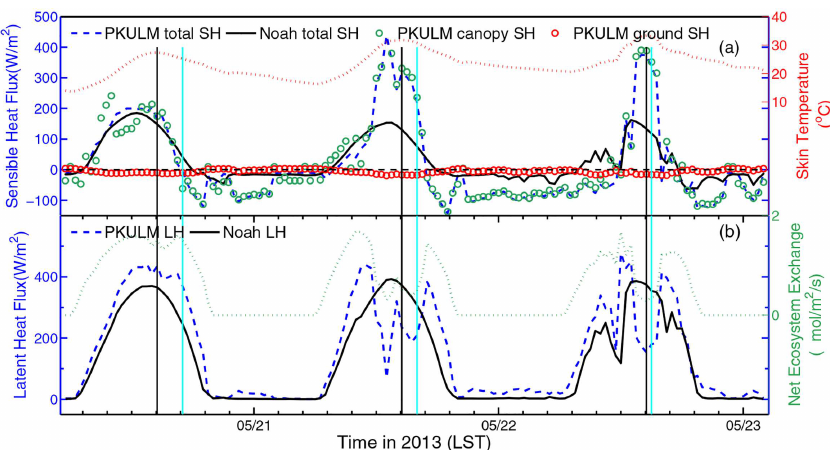
Fig 7. Heat flux simulation by WRF, PKULM respectively (left axis), with skin temperature and NEE (right axis) in 2013. Total sensibleheat flux simulatedby the two models, and (a) sensibleflux of canopy and ground by PKULM, (b) latent heat flux simulated by the two models. For both two panels, the black meridional lines indicate the time when skin temperaturepeaks while the cyan lines indicate the time when in-situ observed 2 m temperaturepeaks (refer to previouslyin Fig